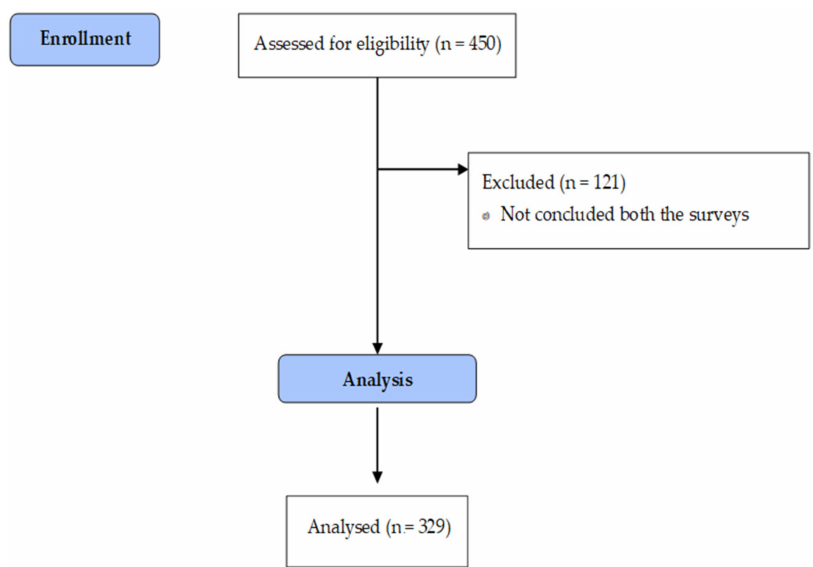
Figure 1. Participants’ flow-chart.